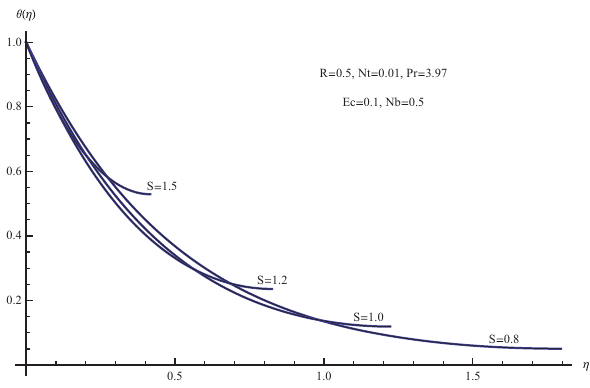
Figure 3: ( ) θ η for assorted quantities of S .